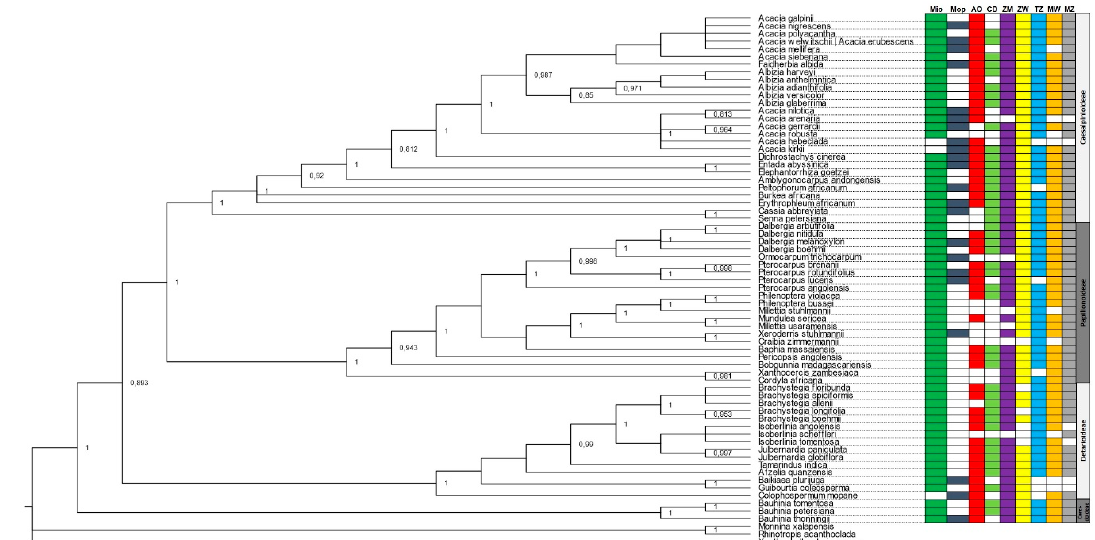
Figure 3. Phylogenetic tree of the Leguminosae tree species from Miombo and Mopane ecosystems. The phylogeny was constructed with three selected genes (ITS + matK + rbcL) using the Bayesian inference (BI) method. Acronyms for the countries/regions: Mio—Miombo; Mop—Mopane; AO—Angola; DRC—Democratic Republic of the Congo; ZM—Zambia; ZW—Zimbabwe; TZ—United Republic of Tanzania; MW—Malawi; MZ—Mozambique.